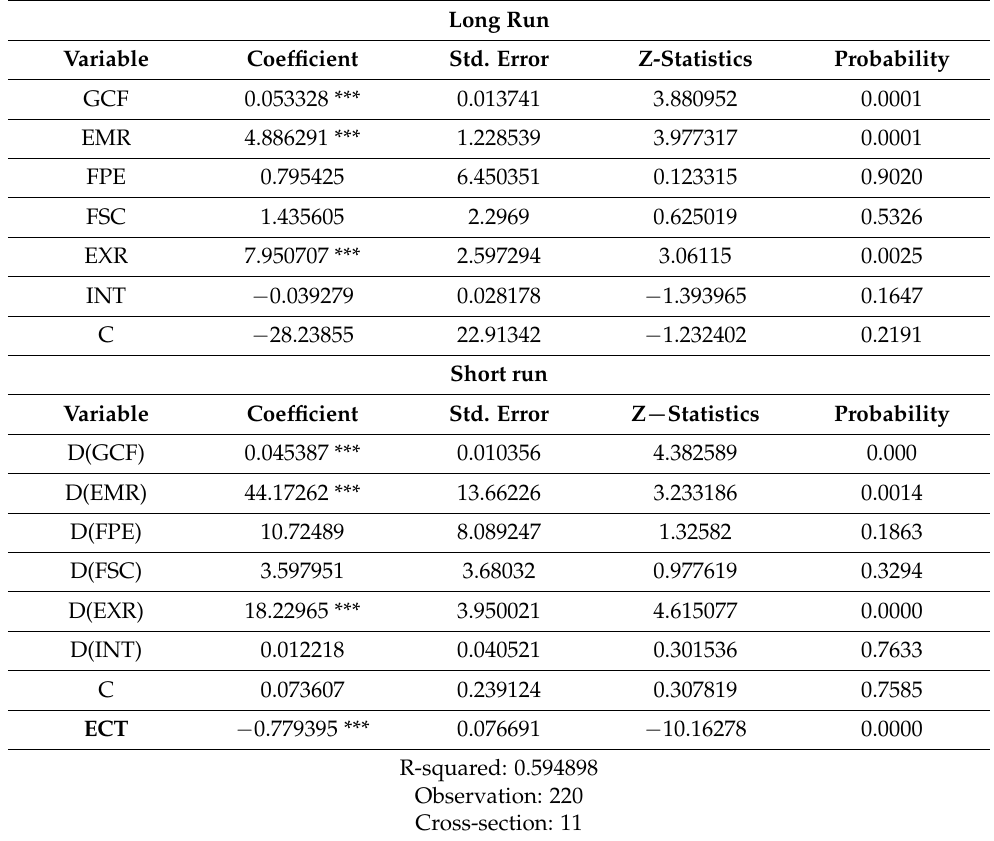
Table 3. CS-ARDL Estimation Result for Factor Accumulation